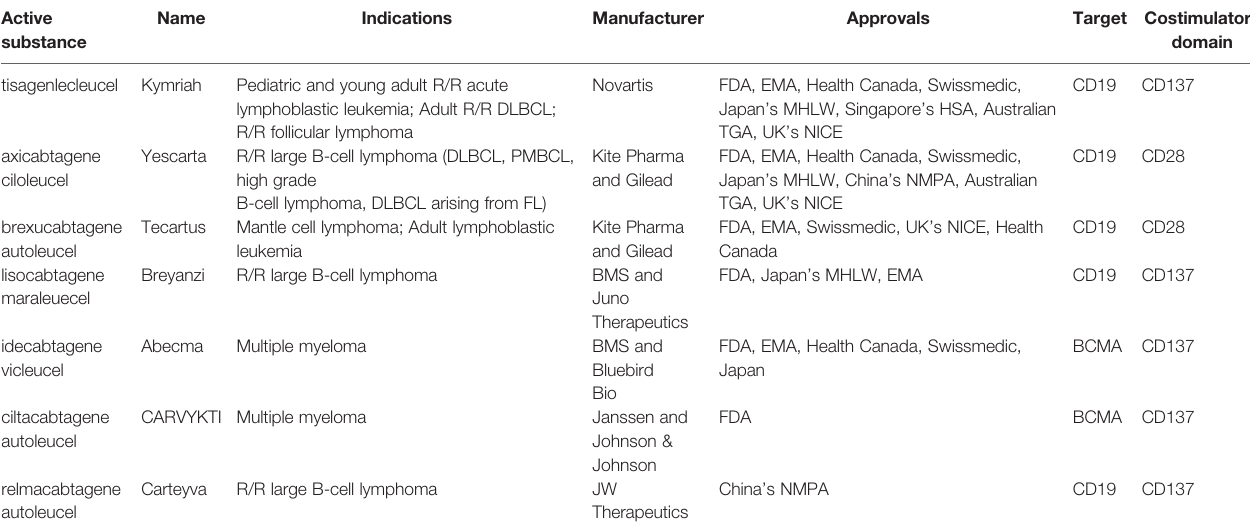
TABLE 1 | Commercial CAR T products and their indication and availability